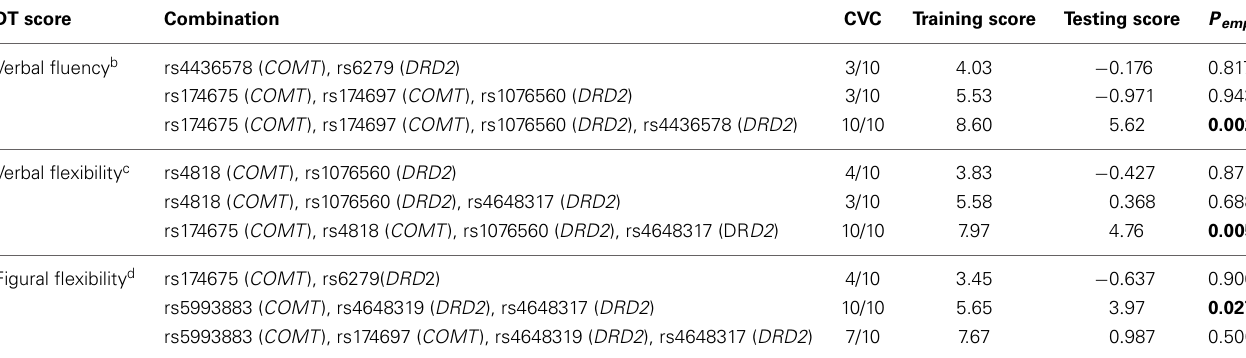
Table 5 | Selected results of gene–gene interaction analysis for creative potential a